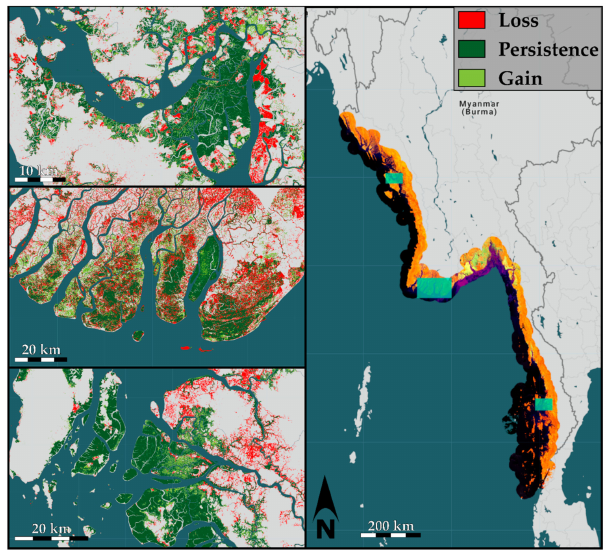
Figure 9. ( Left ) panels: Known mangrove loss hotspots (Figure 1). ( Top left ) shows loss, persistence, andgain(LPG)from2004–2008to2014–2018inRakhineState; ( middleleft )panelshowstheAyeyarwady Region; ( bottom left ) shows Tanintharyi Region. ( Right ) Panel: contemporary high tide (HOT) image composite, false colour (R: NIR G: SWIR B: Red) with boundaries of left panels highlighted in